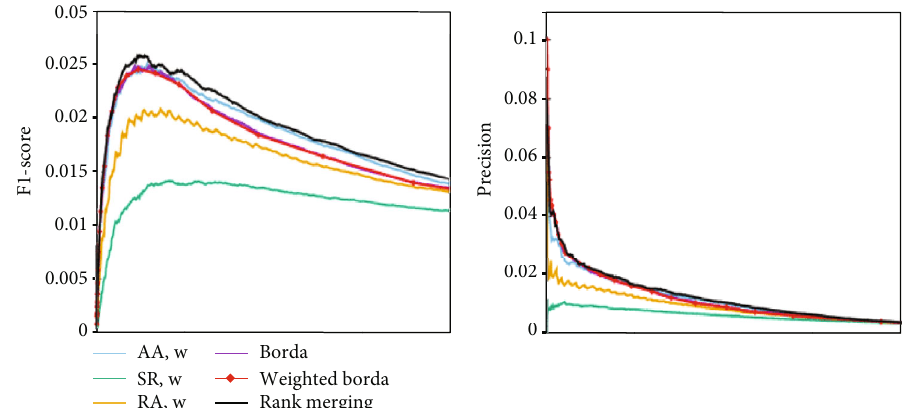
Figure 1: The relationship existent in a social network using the concept of link prediction. To be speci fi c, Facebook data. F1 score is used as a function of the prediction numbers [4].